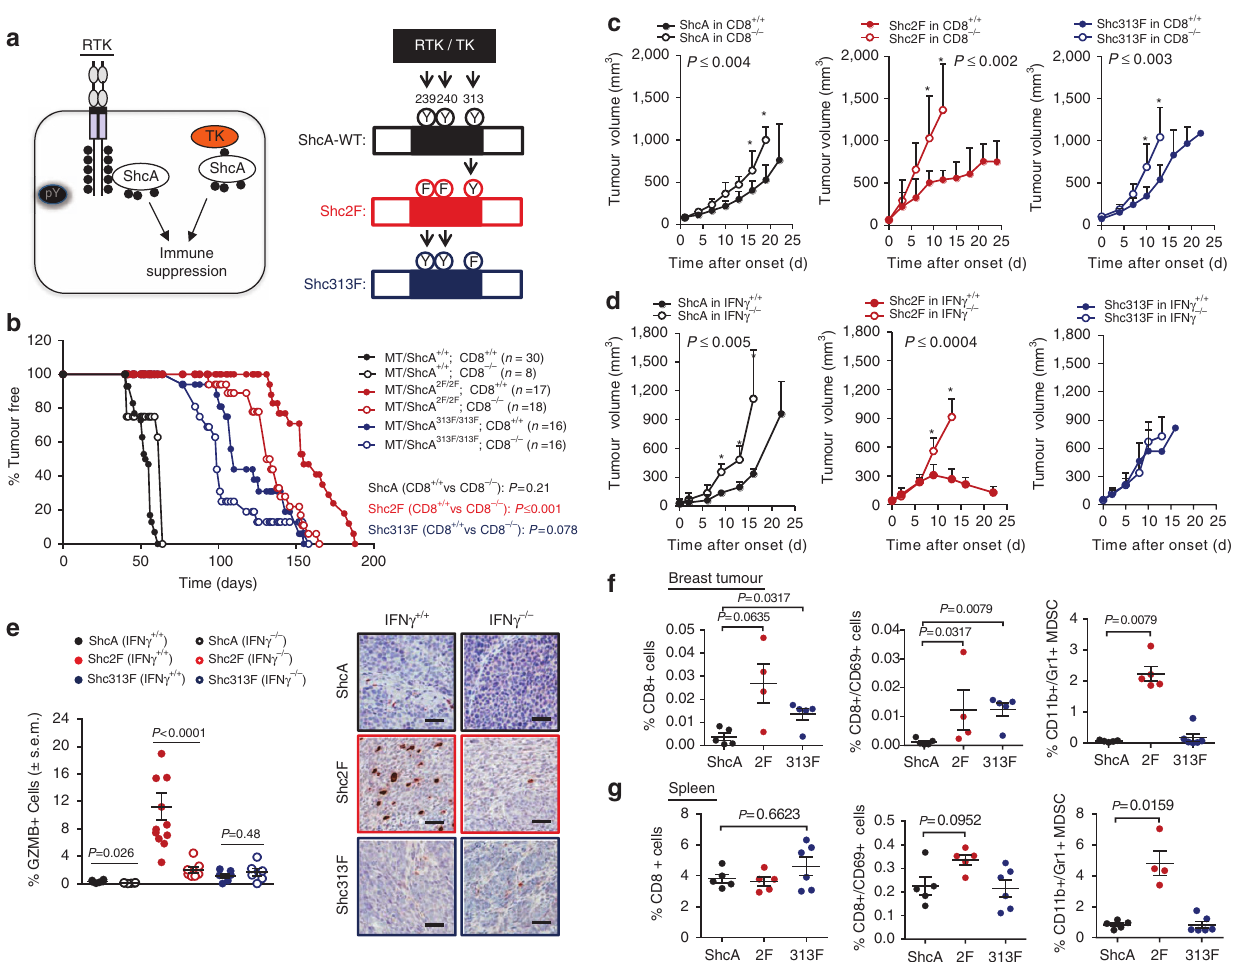
Figure 1 | Phosphotyrosine-dependent ShcA signalling promotes breast cancer immune suppression. ( a ) Schematic diagram illustrating engagement of TK/ShcA signalling complexes to promote immune suppression. ( b ) MMTV/MT transgenic mice of the indicated genotypes were evaluated for mammary tumour onset. Percentage of tumour-free mice over time. Number ( n ) of mice analysed is indicated. ( c , d ) Cell lines derived from MT-driven transgenic mammary tumours that are homozygous for WT ShcA (864) or phosphotyrosine-deficient ShcA mutants (Y313F (313F-6738)) or Y239F/Y240F (2F-5372) were injected into the fourth mammary fat pad of FVB, CD8 (cid:2) / (cid:2) or IFN g (cid:2) / (cid:2) mice. Tumour outgrowth was measured and represented as mean tumour Granzyme B (GZMB)-specific antibodies. The data are represented as percentage GZMB þ cells relative to total cells per field ± s.e.m. Representative images are shown. Scale bars, 50 m m. ( f , g ) Flow cytometric analysis of immune infiltrates into MT/ShcA þ / þ (864), MT/Shc 2F/2F (5372) and MT/Shc 313F/313F (6738) ( f ) tumour tissue or ( g ) matching spleen derived from FVB mice. Presence of CD8 þ cells, CD8 þ CD69 þ cells and CD11b þ Gr1 þ MDSCs ( n ¼ 4–6 mice per group). The data are represented as percentage of each cell type relative to total cells analysed ± s.e.m. Significance was determined by Wilcoxon’s rank-sum test for e – g , by multiple t -test with Holm–Sidak method for c , d (*statistically significant time points as indicated in the top left corner), and by two-tailed two sample t -test for a , b